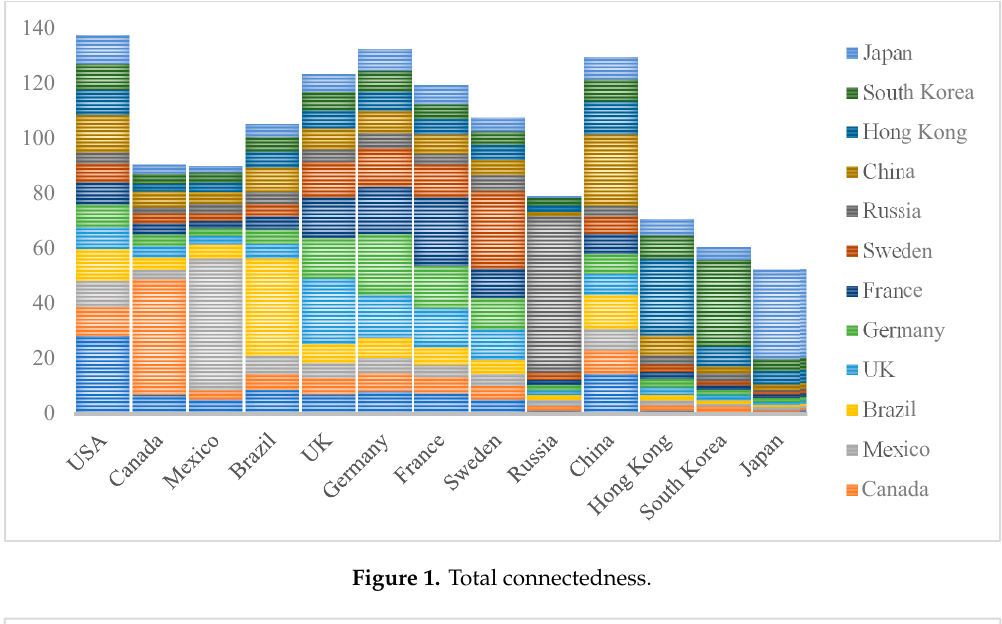
Figure 1. Total connectedness.